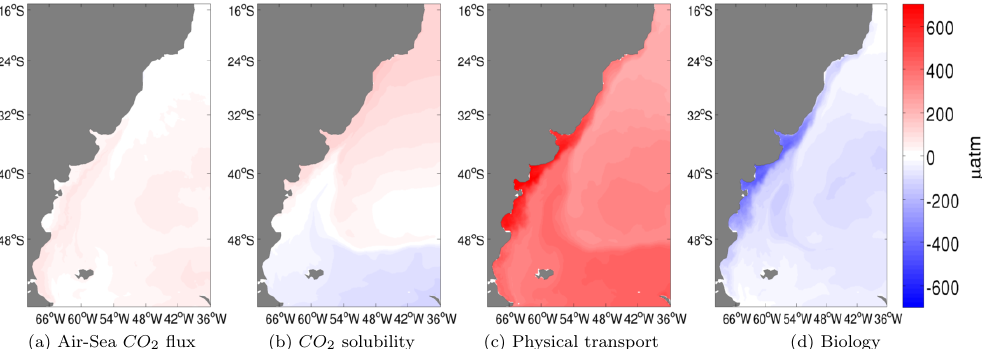
Figure 7. Processes driving the annual mean surface p CO 2 . Contribution of Air-sea flux of CO 2 [Control–E1] (a) , CO 2 solubility [E2–E3] (b) , physical transport [E3] (c) and biological production [E1–E2] (d)